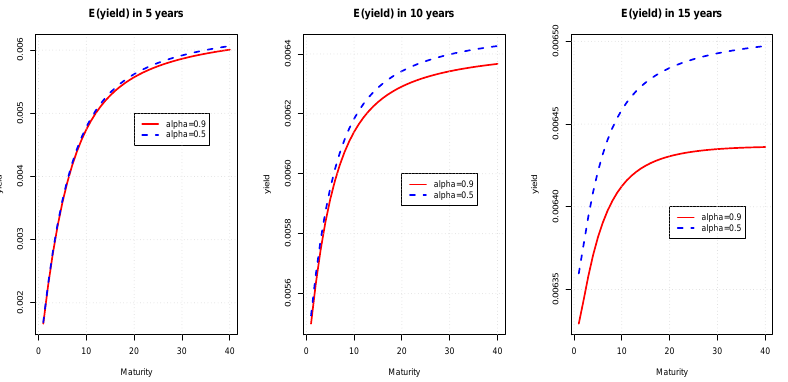
Figure 5. Expected yield curves in 5, 10 and 15 years; α = 0.5 and 0.9; β = 1.5; λ 1 = 0.5; η 1 = − 0.002; σ 1 = 0.01. ML kernel with n = 40 atoms.